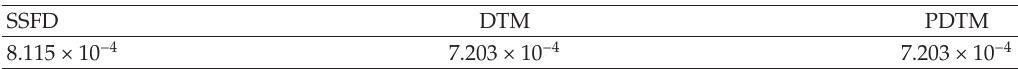
Table 6: Comparison for the L ∞ errors between the exact solution and approximate solutions obtained by SSFD, DTM, and PDTM at t (cid:7) 4. SSFD DTM PDTM 8 . 115 × 10 −